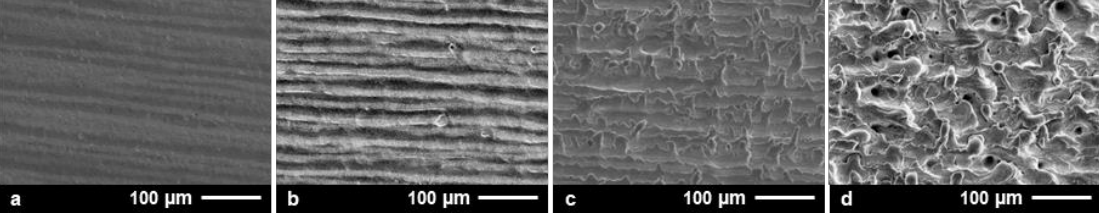
Figure 2. Laser surface textures produced on AISI 304 by raster-scanning of the laser beam across the substrates at 3.0 µm ( a ), 1.5 µm ( b ), 0.9 µm ( c ), and 0.6 µm ( d ) intra-line pulse distance.